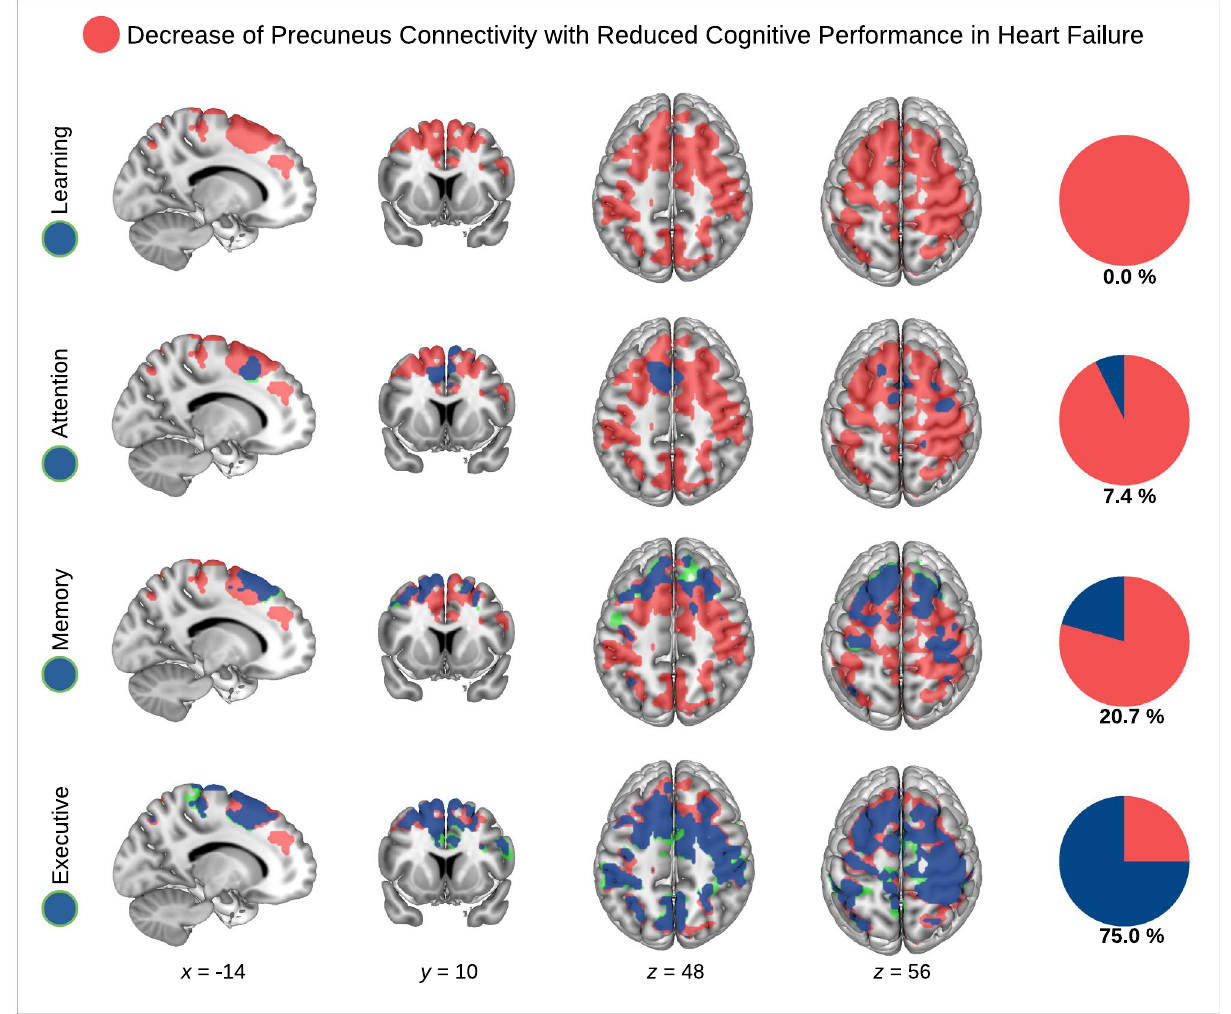
between the factors HF and cognitive performance was obtained showing a significant group difference (HF vs. no-HF) with respect to decreased precuneus connectivity with lower cognitive performance for the general score across all cognitive domains (red color). In addition to the general score across all cognitive domains, the same analysis was repeated for each of the single cognitive domains, i.e., executive function, attention, memory and learning (green and blue color, overlap with the general score in blue color). Analysis was conducted across all available 75 patients. Pie charts on the right illustrate overlap between neural network for the general cognition score and respective specific cognitive domains (overlap again blue). All analyses were performed using age, sex, body mass index, and precuneus gray matter density as nuisance covariates. Significant results in the voxel-wise analyses were obtained with nonparametric permutation analysis using 10,000 permutations and threshold-free cluster enhancement (TFCE) with family-wise error correction ( p < 0.05). x, y, z —coordinates of the Montreal Neurological Institute (MNI) stereotactic space. L—left,